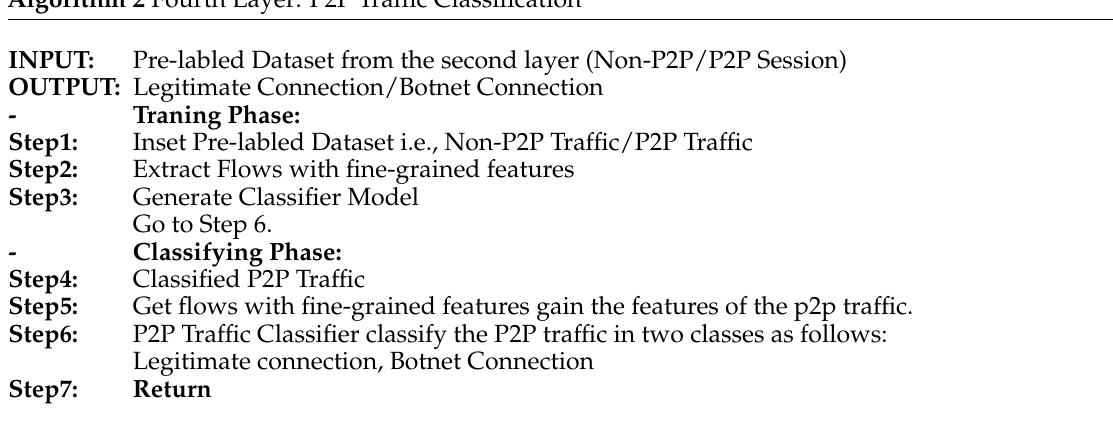
Algorithm 2 Fourth Layer: P2P Traffic